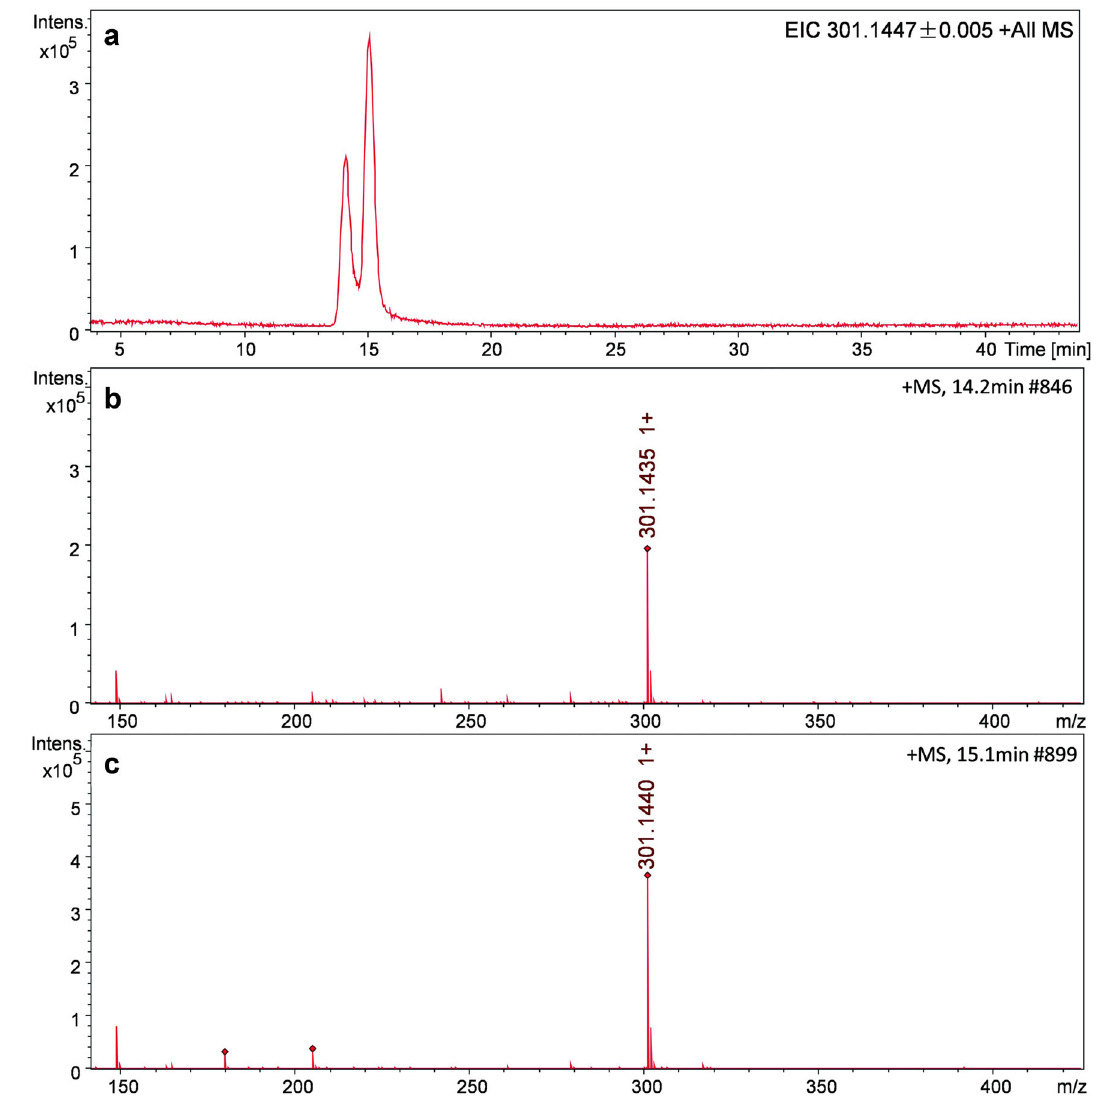
Fig. 7 EIC ( a ) and mass spectra ( b and c ) of isomers of [C 19 H 17 N 4 ] ? ( m / z = 301.1447) detected by